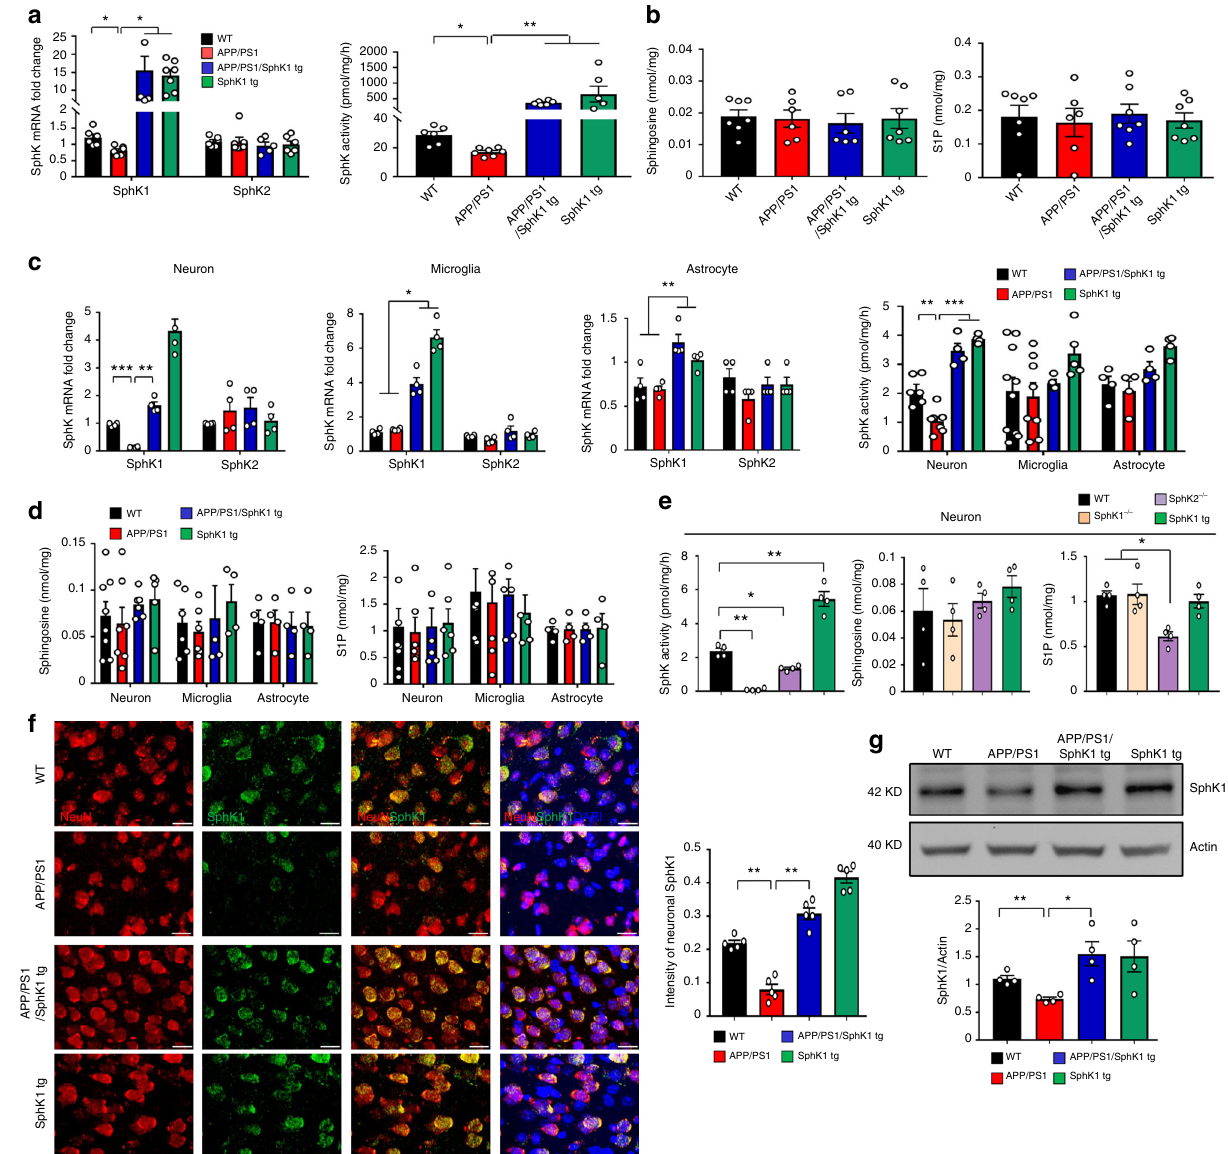
Fig. 1 SphK1 is decreased in APP/PS1 mice neuron. a SphK1 ( n = 6 – 7 per group) and SphK2 mRNA ( n = 5 – 7 per group) and SphK activity ( n = 6 – 7 per group) in cortex of brain. b Detection of sphingosine ( n = 6 – 7 per group) and S1P ( n = 6 – 7 per group) in brain. c SphK1 and SphK2 mRNA ( n = 4 per group) and SphK activity ( n = 4 – 10 per group) in neurons, microglia, and astrocytes isolated from mouse brain. d Detection of sphingosine ( n = 4 – 8 per group) and S1P ( n = 4 – 8 per group) in neurons, microglia, and astrocytes isolated from mouse brain. e Detection of SphK activity, sphingosine and S1P in neurons isolated from WT, SphK1 − / − , SphK2 − / − and SphK1 tg mouse brain ( n = 4 per group). f Left, representative immuno fl uorescence images of cortex showing SphK1 (green) merged with neuron (NeuN, red). Scale bars, 20 μ m. Right, quanti fi cation of neuronal SphK1 ( n = 5 per group). g Western blotting for SphK1 in neuron isolated from mouse brain ( n = 4 per group). All data analysis was performed on 9-month-old mice. a – g One-way analysis of variance, Tukey ’ s post hoc test. * P < 0.05, ** P < 0.01, *** P < 0.001. All error bars indicate but did not detect differences (Supplementary Fig. 4c). Also, the changes of microglia and astrocytes. APP/PS1/SphK1 tg mice expression pattern of proteins related to endocytosis and autop- showed a signi fi cant reduction of activated microglia and hagy showed no differences between the groups (Supplementary astrocytes compared to APP/PS1 mice (Fig. 2c, d). In addition, Fig. 4d, e). Our results indicated that apoptosis, processing of APP/PS1/SphK1 tg mice showed a decrease of pro-in fl ammatory APP, modulation of the endocytic pathway and autophagy were markers, including TNF- α , IL-1 β , IL-6 and iNOS , and immunor- not related with the increase of SphK1 in the APP/PS1/SphK1 tg egulatory cytokine IL-10 , and an increase of anti-in fl ammatory mouse. markers, including IL-4, TGF- β and Arg1 , compared with APP/ PS1 mice (Fig. 2e). Collectively, these data indicated that genetic SphK1 overexpression could improve the in fl ammatory response in AD brains, and that regulation of neuroin fl ammation might be an important mechanism that attenuates AD pathology by increased neuronal SphK1.